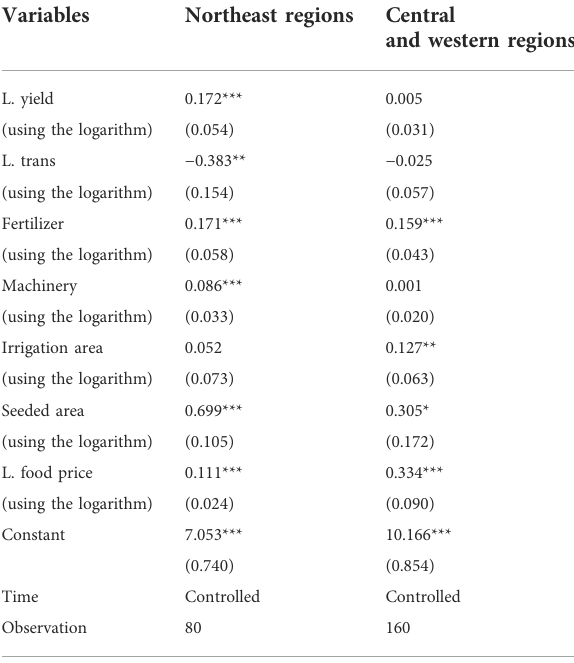
TABLE 4 Impact of ALT on grain output in different regions in China. TABLE 5Resultsof the mediation effect of agricultural mechanization